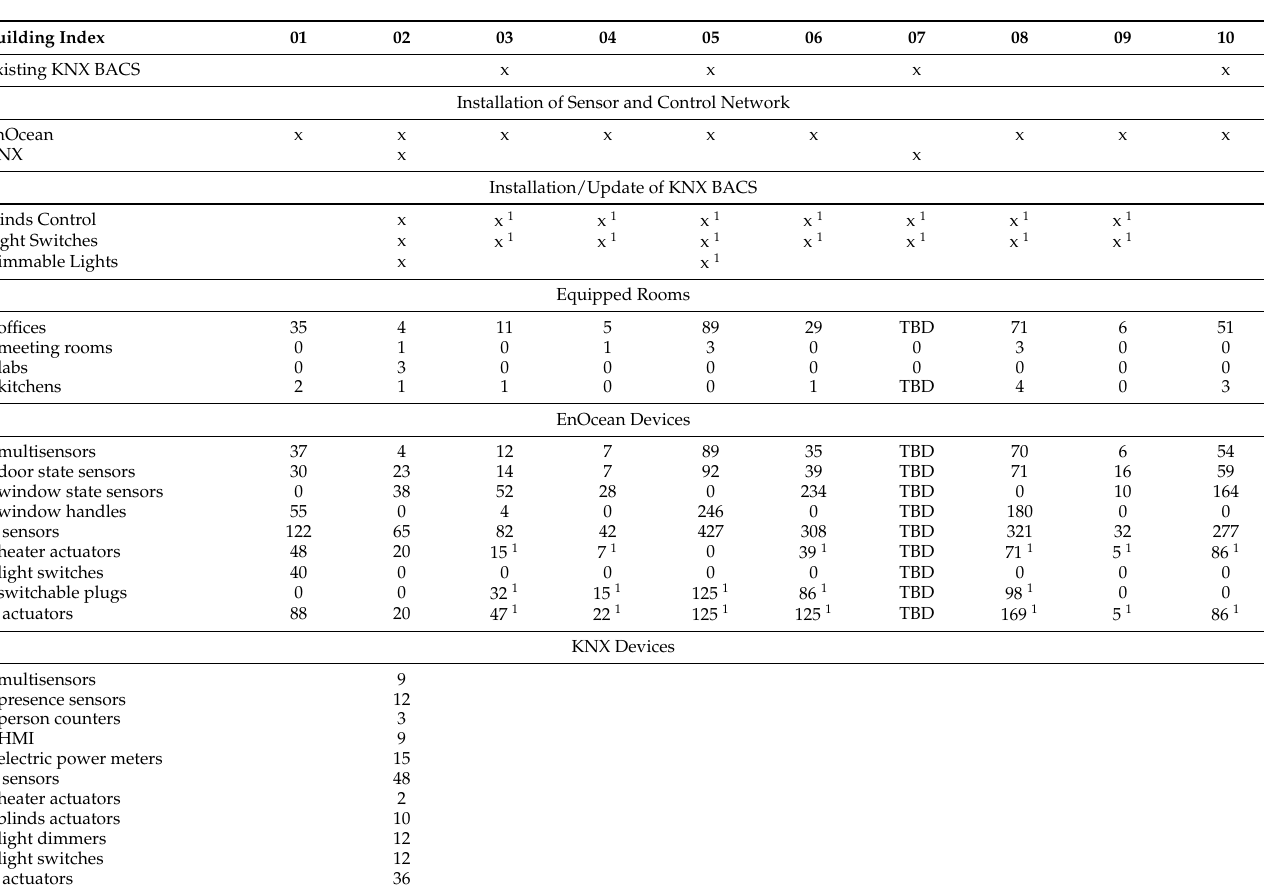
Table 6. Overview of preexisting, updated, and newly installed sensor and control networks for the buildings in Group